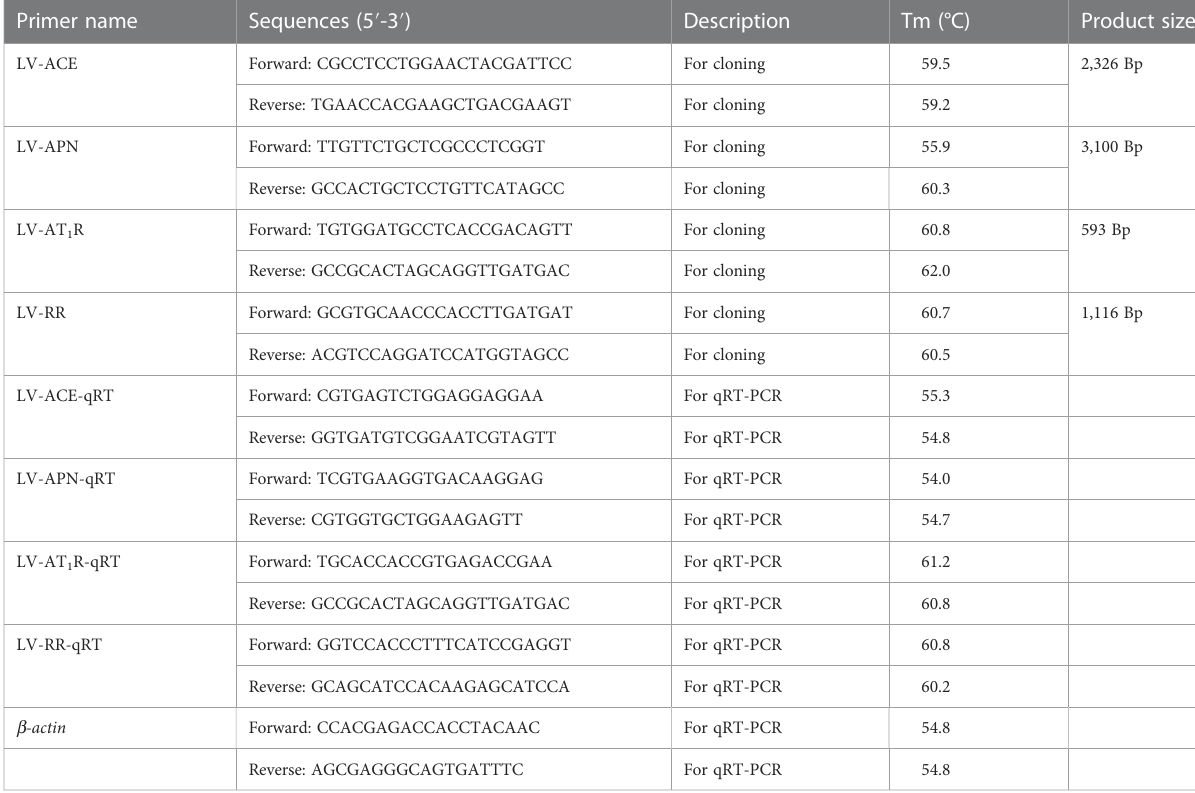
TABLE 1 Primers used for cloning and qRT − PCR of LV-ACE , LV-APN , LV-AT 1 R , and LV-RR . Primer